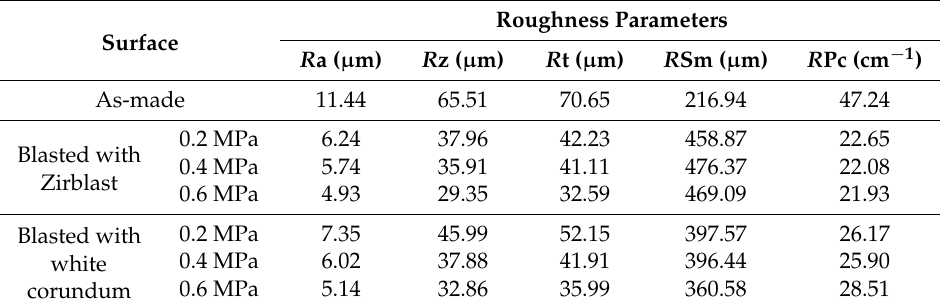
Figure 12. Profiles of materials as ‐ made and blasted. ( a ) as ‐ made; ( b ) Zirblast, 0.6 MPa; ( c ) White corundum, 0.6 MPa. Table 5. Average values of the roughness parameters.